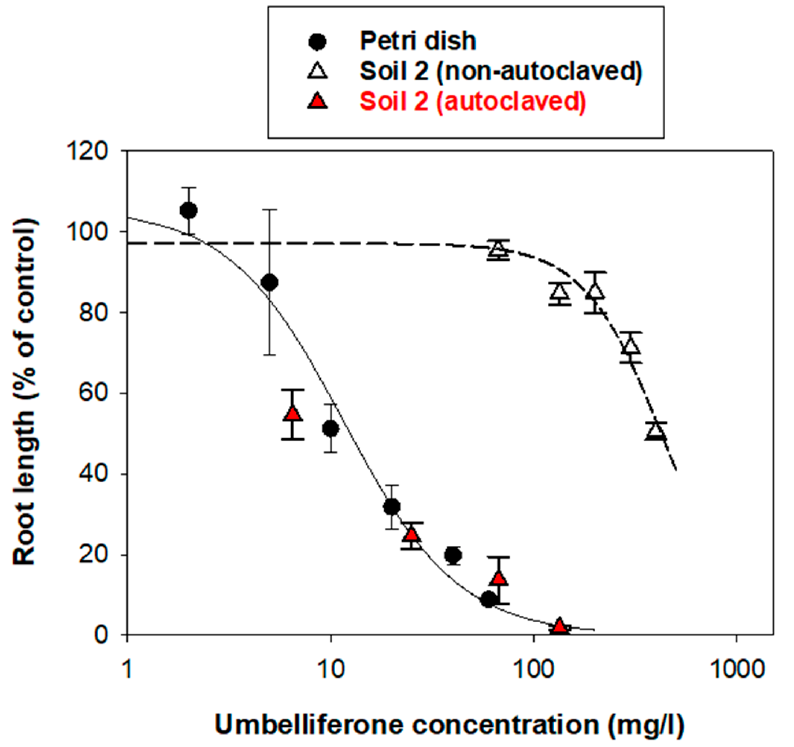
Figure 5. Dose-response curves for the inhibitory effect of umbelliferone on the root growth of E. sativa under Petri dish conditions and in the presence of non-autoclaved and autoclaved soil 2 (t = 6 days).